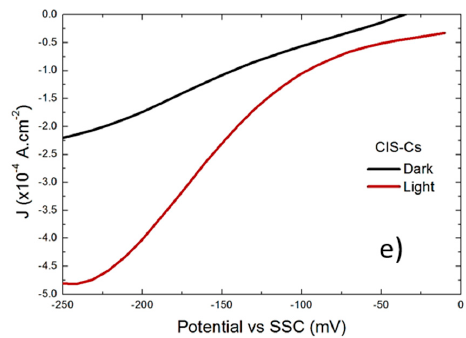
Figure 3. Photocurrent response of the alkaline-doped CIS films: ( a ) undoped, ( b ) CIS:Li, ( c ) CIS:Na, ( d ) CIS:K, and ( e ) CIS:Cs.